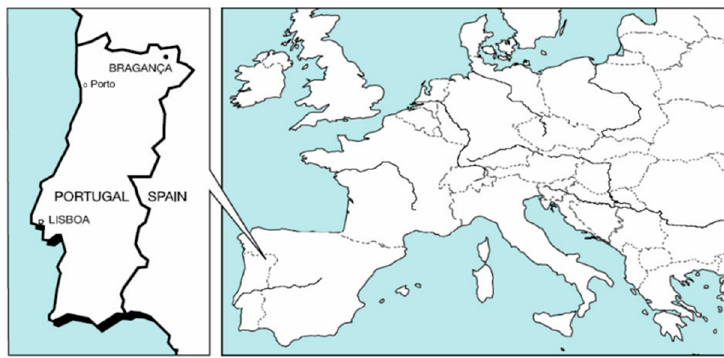
Figure 1. Location of the city of Bragança (Portugal).